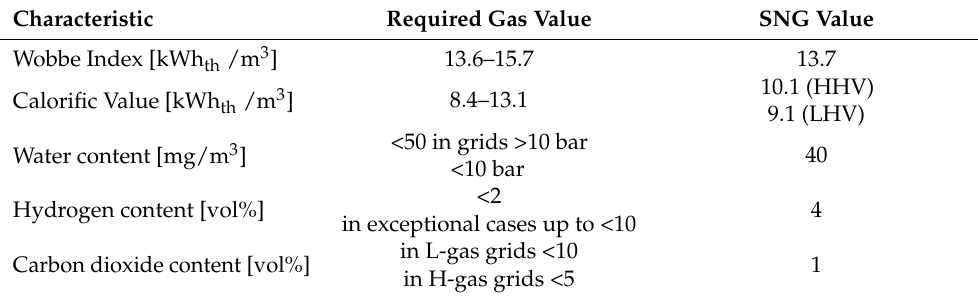
Table 7. Comparison of produced SNG and German gas injection requirements. Values according to the DVGW G 260 standard [25].